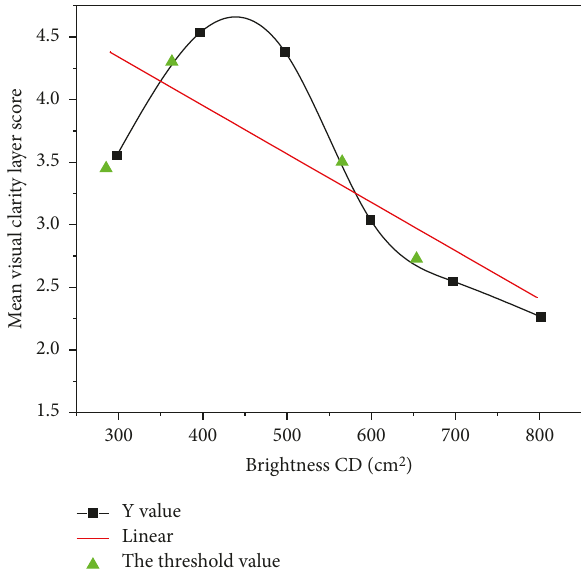
Figure 8: Variation trend of visual comfort and brightness.